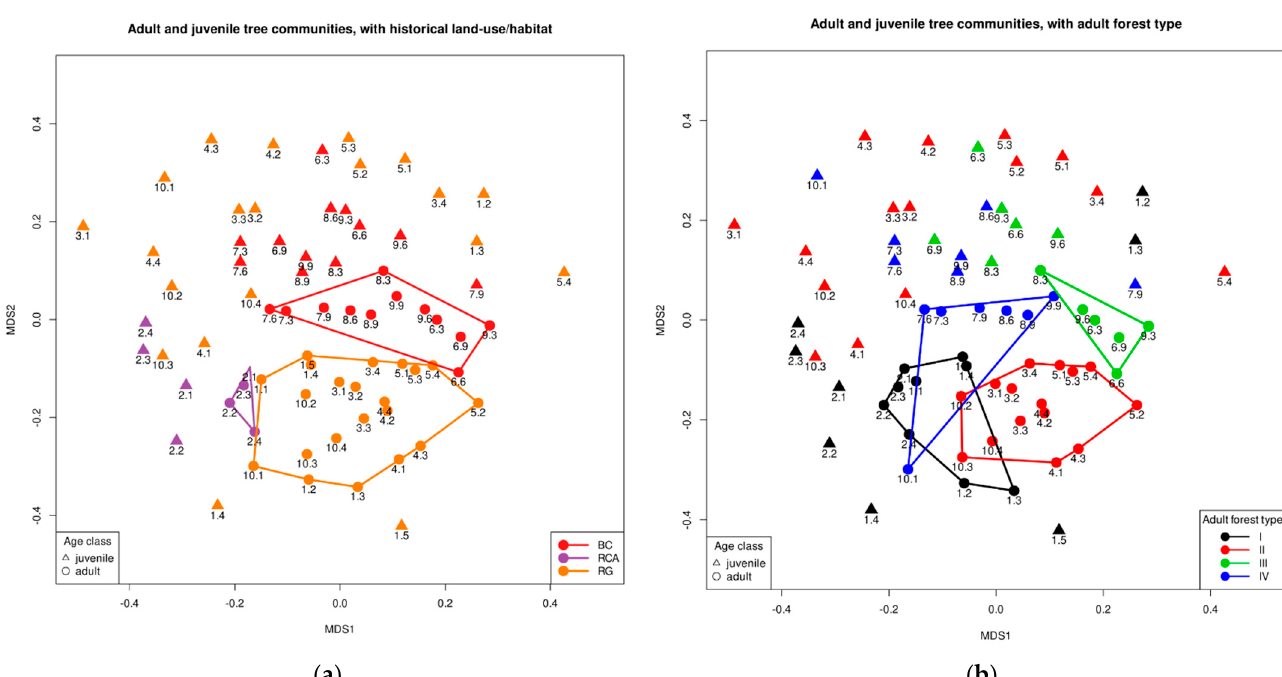
Figure 9. Nonmetric multidimensional scaling (NMS) ordination of combined juvenile and adult tree communities using Bray–Curtis dissimilarity. Only sites with both juvenile and adult data are shown. Each site therefore had two points, a juvenile (triangle) and adult (circle) tree community. ( a ) Ordination colored by historical land use. Hulls are drawn around adult communities. ( b ) Ordi- nation colored by current ecological state (“forest type”). Hulls are drawn around adult communi- ties.